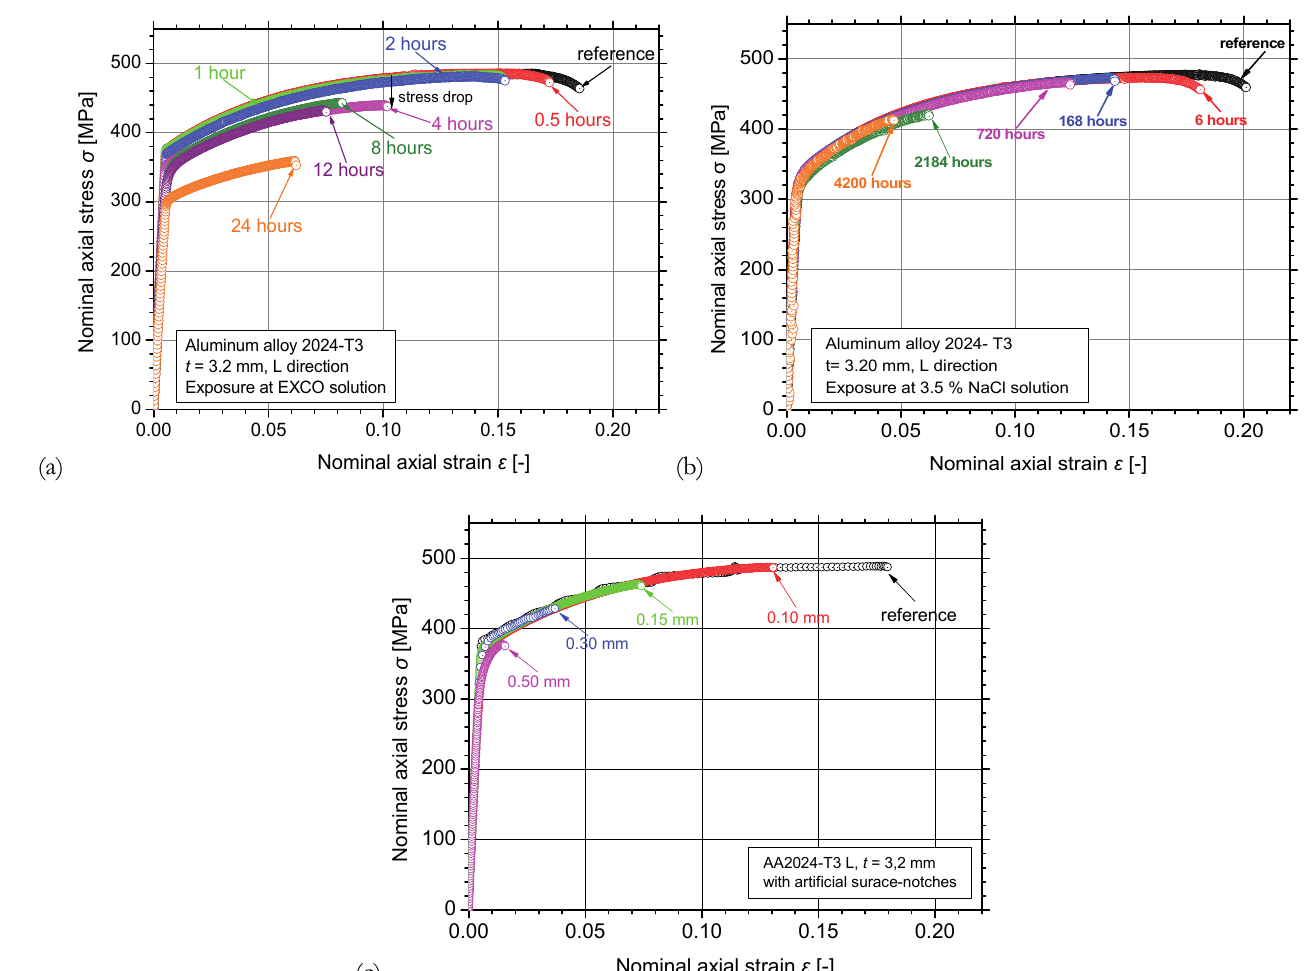
Figure 3: Typical tensile nominal stress - strain curves of AA2024-T3 after corrosion exposure for different exposure times to (a) EXCO solution, (b) 3.5 wt. % NaCl solution and (c) varying depth of artificial surface notches.